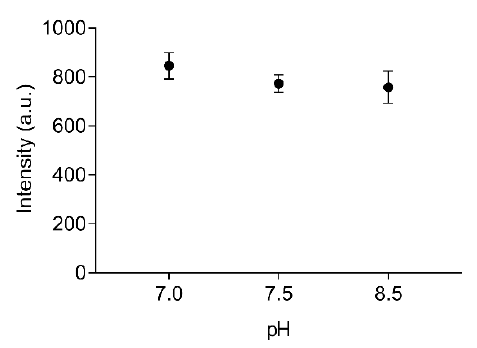
Figure 3. Fluorescence transfer intensity (arbitrary units, mean ± SD, n = 3) between the tryptophan residues and the IAEDANS of 67 nM of labelled EST2-S35C, using 25 mM NaH 2 PO 4 at pH 7.0 and 25 mM Tris/HCl at pH 7.5 and 8.5 as media.